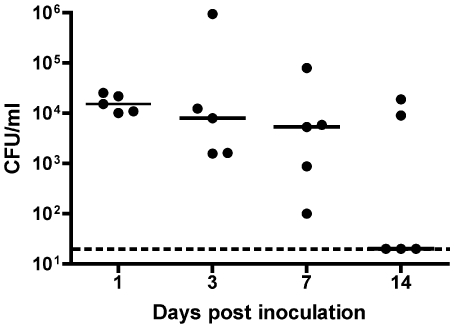

K. pneumoniae colonizes the nasopharynx of C57BL/6 mice.C57BL/6 mice were inoculated intranasally with 2×106 cfu of an overnight LB culture of KPPR1 in 10 µL PBS. At each time point, 5 mice were sacrificed, nasopharyngeal lavage was performed, and lavage fluid was plated for quantitative culture. Colony forming unit (cfu) counts are shown as a scatter plot where the bar represents the median; the dashed line is the lower limit of detection (20 cfu/ml).